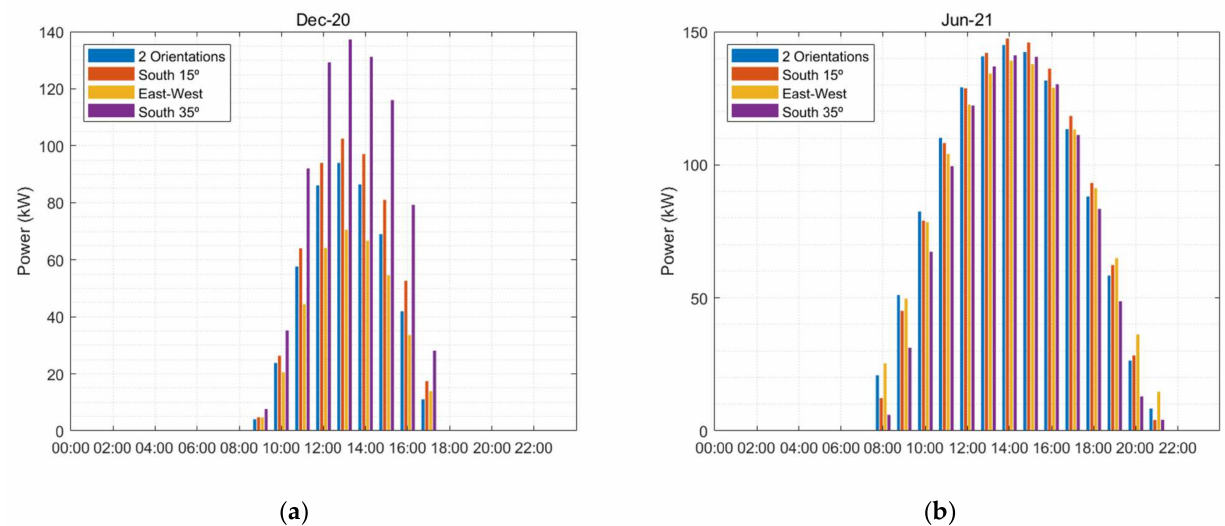
Figure 11. PV production of the different configurations rescaled to the same rated power for industrial PVSCS on clear-sky days with extreme solar trajectories. ( a ) Winter solstice, ( b ) Summer